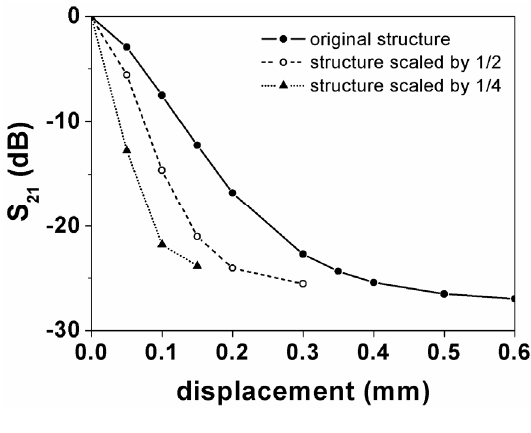
Figure 9. Comparison between the notch depth given by electromagnetic simulation for the structure of Figure 7 and for the same structure with all dimensions scaled